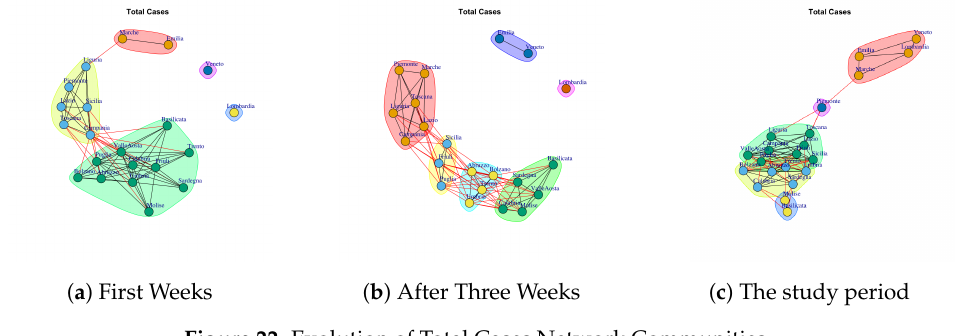
Figure 22. Evolution of Total Cases Network Communities.